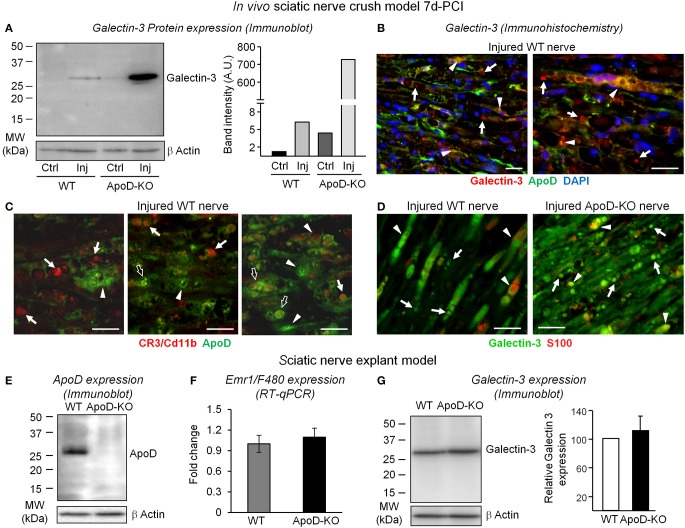
ApoD-dependent changes in the levels of Galectin-3 expression in nerves 7d-PCI and cultured nerve explants. (A) Immunoblot analysis of Galectin-3 in the region distal to the lesion of WT and ApoD-KO mice sciatic nerves. The induction of Galectin-3 protein expression by injury is exacerbated in the ApoD-KO nerves at 7d-PCI. Basal expression of Galectin-3 in ApoD-KO nerves is also increased compared to WT nerves. (B) Representative micrographs of Galectin-3 and ApoD immunofluorescence experiments in crushed WT nerves 7d-PCI. Arrows point to Galectin-3 labeling in macrophages, and arrowheads indicate co-localization of ApoD and Galectin-3 in SCs and myelin profiles. (C) CR3/Cd11b and ApoD labeling in sagittal sections of the injury region of WT nerves 7d-PCI. CR3/Cd11b-positive macrophages do not express ApoD (arrows), which is present in other cells and in myelin profiles (arrowheads). However, some macrophages show partial co-localization with ApoD-positive myelin profiles (open arrows). (D) Galectin-3 and S100 labeling in sagittal sections of the injury region of WT and ApoD-KO nerves 7d-PCI. Galectin-3 labeling is more abundant in ApoD-KO nerves, and often co-localizes with S100-positive SCs in the injured nerves. (E–G) Analysis of nerve explants cultured for seven days. The graphs represent the average ± SD of 3 independent culture experiments. (E) Immunoblot analysis of ApoD shows high levels of expression in the WT cultured nerves. (F) Emr1/F4-80 mRNA expression does not differ between ApoD-KO and WT nerve explants, indicating similar presence of endogenous macrophages. (G) Immunoblot analysis of Galectin-3 shows no significant increment of expression in ApoD-KO compared to WT nerve explants. Protein band intensities were normalized to β-actin. Calibration bars: 25 μm. Statistical differences were assayed by Student's t-Test.